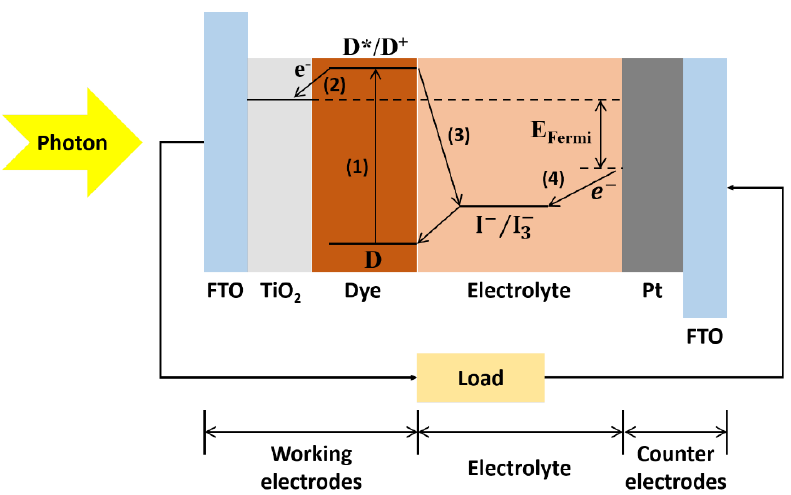
Figure 1. Schematic and working principle of DSSCs.